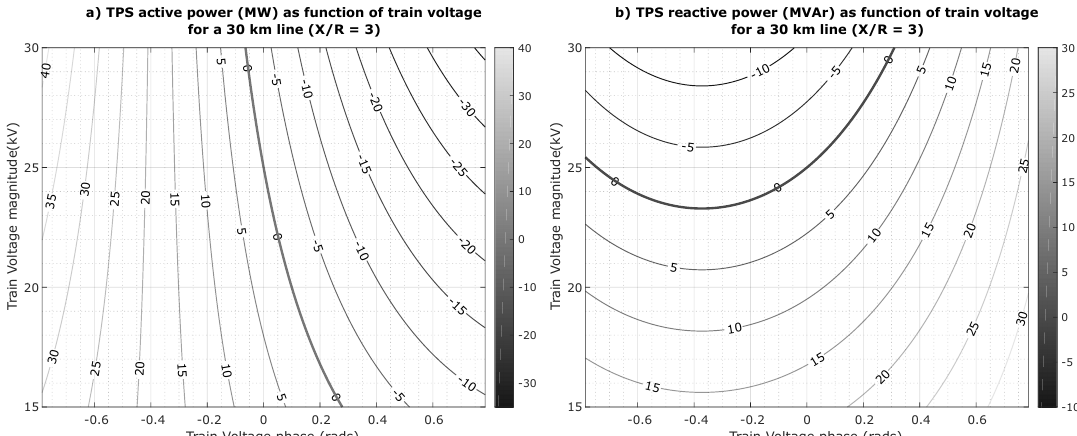
Figure 2. Sensibility analysis for different conditions of train voltage and phase: ( a ) Active power flow at TPS; ( b ) Reactive power flow at